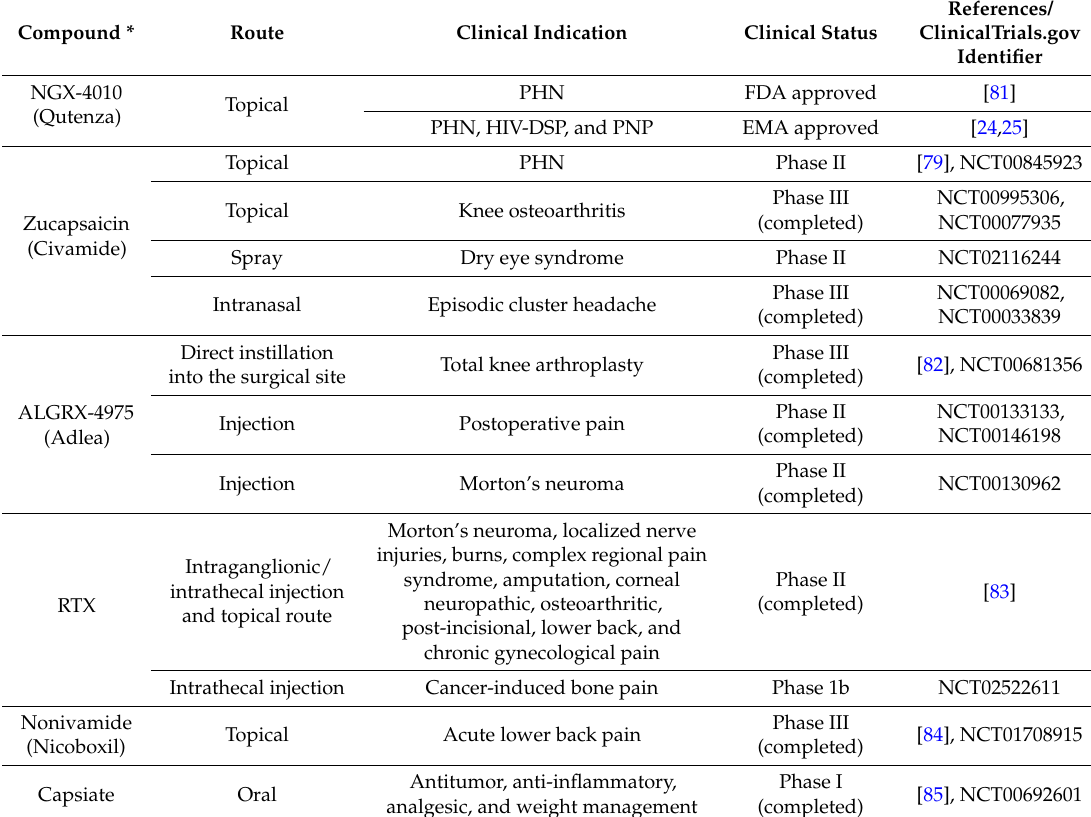
Table 1. Clinical status of capsaicin derivatives as agonists in